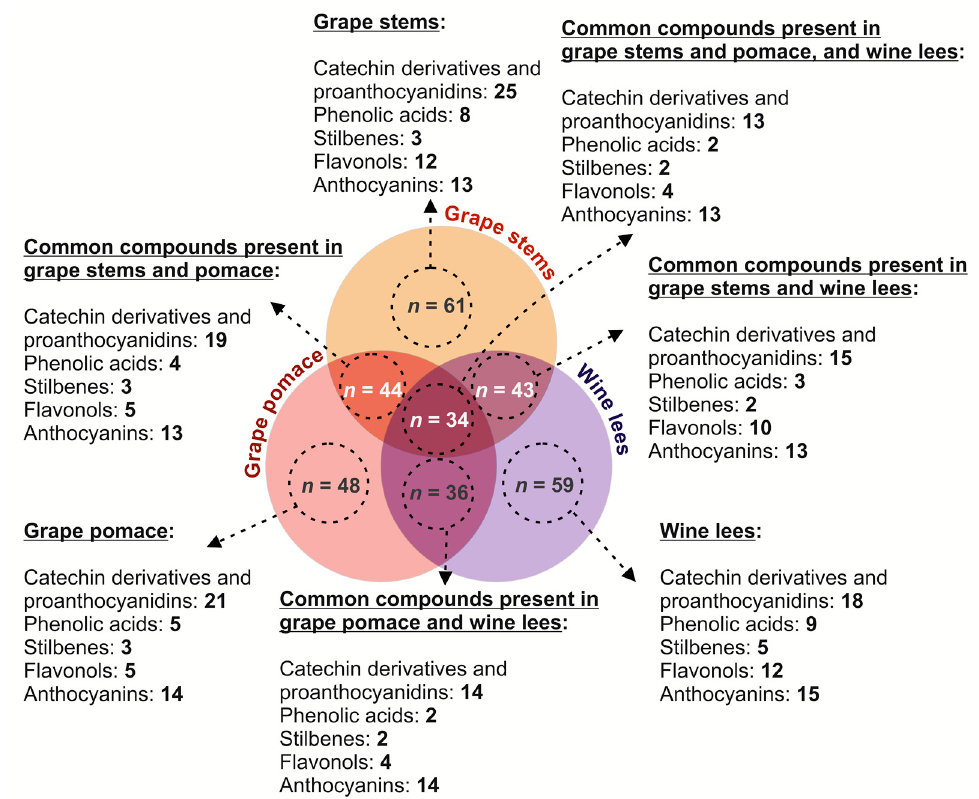
Figure 1. Schematic representation of the diversity of phenolic compounds identified in grape stems, grape pomace, and wine lees. Identity of the phenolic compounds.